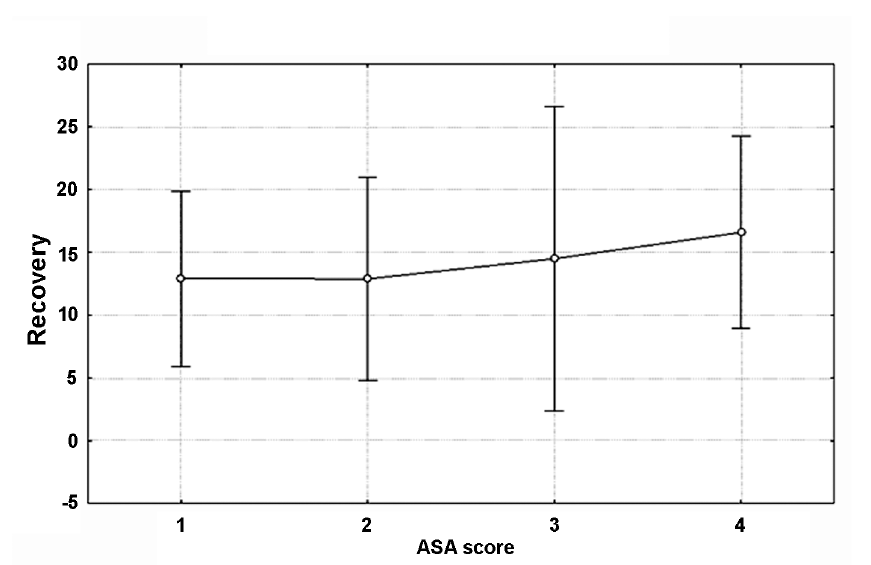
Figure 2 – One way ANOVA with Tuckey correction for multiple comparisons. Patients with a higher preoperative ASA score exhibited a slight but insignificant tendency to a prolonged recovery time.